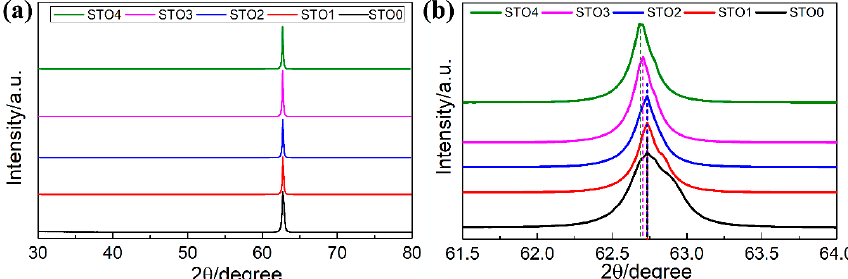
Figure 3. ( a ) X-ray diffraction (XRD) patterns of pure TiO 2 (STO0) and TiO 2 @SrTiO 3 heterostructured nanowire arrays, ( b ) the enlarged X-ray diffraction (XRD) patterns between 61.5° and 64.0°.